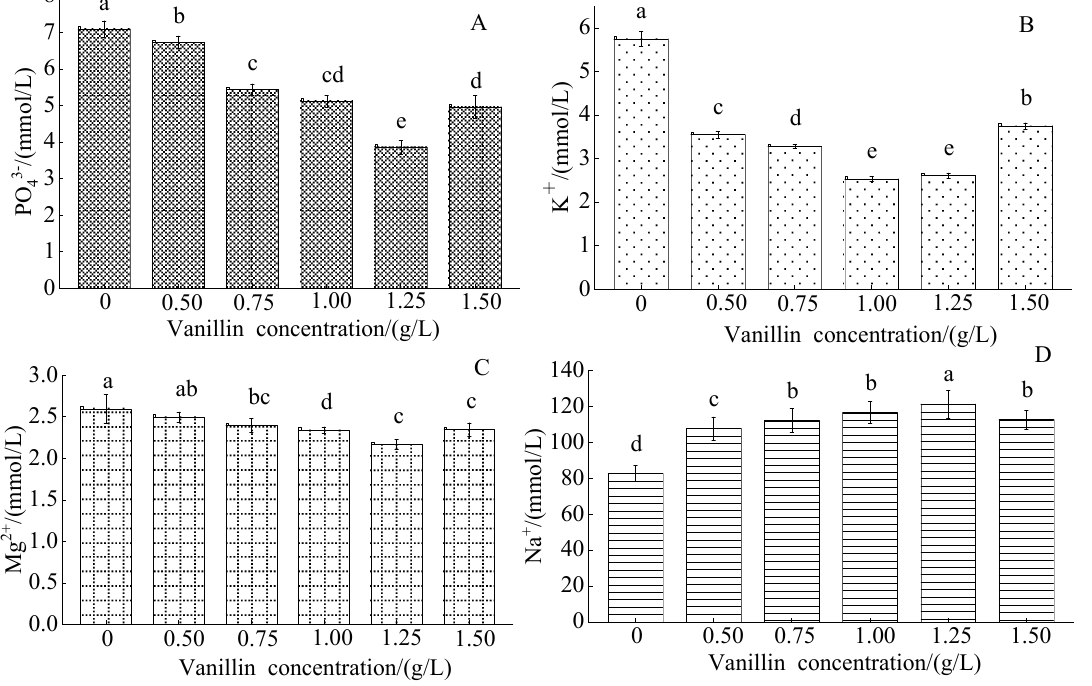
Figure 4. Effect of vanillin concentration on the blood serum ion content of crucian carp: ( A ) phosphate (PO 43 − ); ( B ) potassium (K − ); ( C ) magnesium (Mg 2 + ) ; and ( D ) sodium (Na + ). Different letters above the columns indicate a significant difference ( p < 0.05); the same letter indicates no significant difference ( p > 0.05).